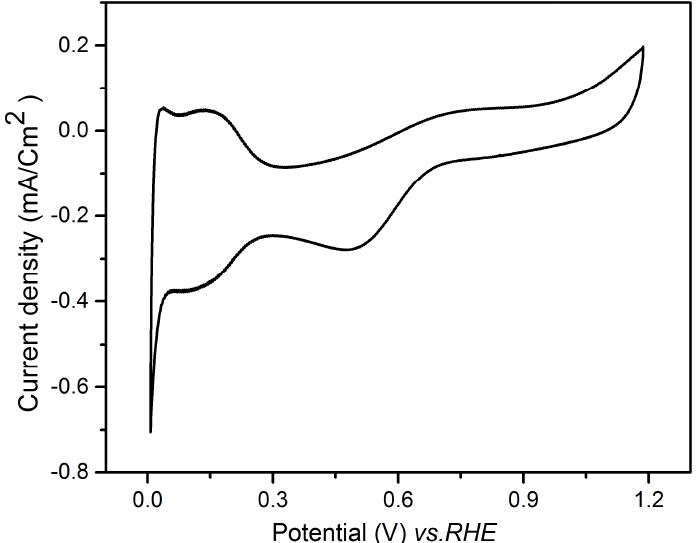
Figure 9. Cyclic voltammogram recorded in 0.1 M HClO 4 on Au/Te electrode after five galvanic replacements with Pt.